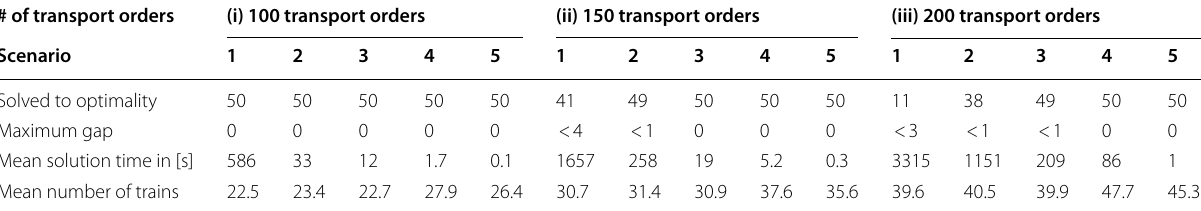
Table 1 Characteristic values of the optimisation